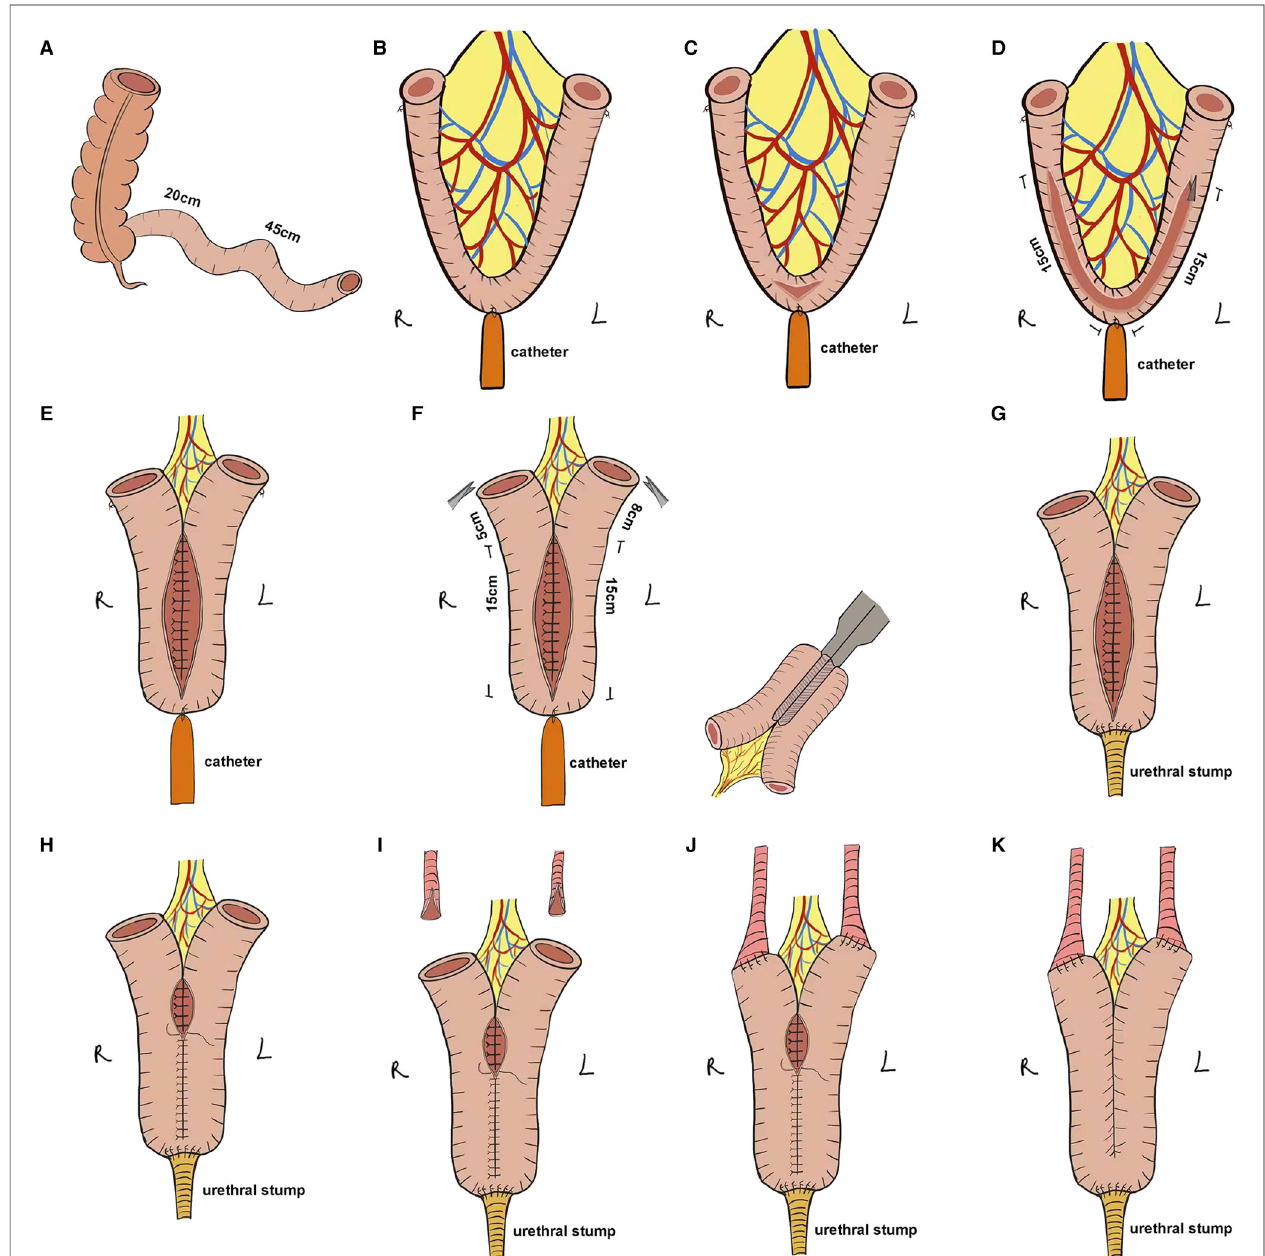
FIGURE 2 | Stepwise con fi guration of the complete Y-shaped ileal neobladder. ( A ) Approximately 45 cm of ileum was separated for ONB. ( B ) The ileo-urethral anastomosis zone and the ends of the ONB ileum were marked, and the catheter was connected to the ileo-urethral anastomosis area to keep the bowel in tension. ( C ) The intestine between the ileo-urethral anastomosis area and the mesentery was dissected. ( D ) Using the ureteric stent as a ruler, 15 cm of the bowel along each side of the marker was separated. ( E ) The dorsal sides of the left and right intestinal canals were sutured throughout. ( F ) The intestinal canal was truncated at 8 cm from the end of the right intestinal canal suture and 5 cm from the end of the left intestinal canal suture, and the stapler laterally anastomosed the intestine to preserve the intestinal continuity. ( G ) The intestinal wall of the ileo-urethral anastomosis area was anastomosed clockwise to the urethral stump. ( H ) The anterior wall was sutured to the reservoir. ( I ) The ureter was split 1 cm at each end. ( J ) Wallance anastomosis was performed to suture the ends of the ureter to the Y-shaped arms on either side of the reservoir in a continuous manner. ( K ) The remaining anterior wall of the reservoir was